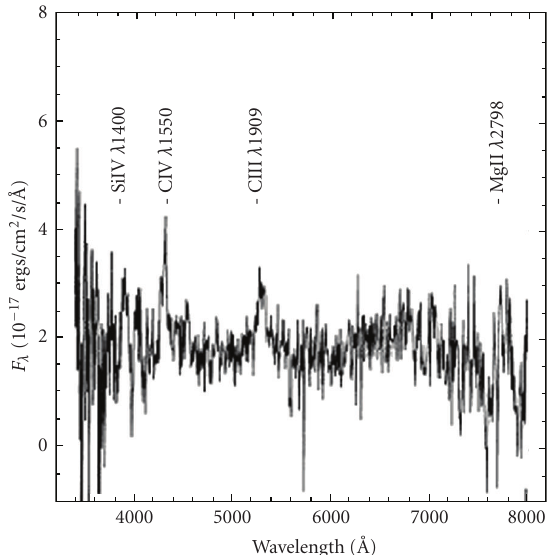
Figure 9: The spectrum of the object 41 inside the OT error box from previous figure. This is a candidate object for the OT, probably a faint